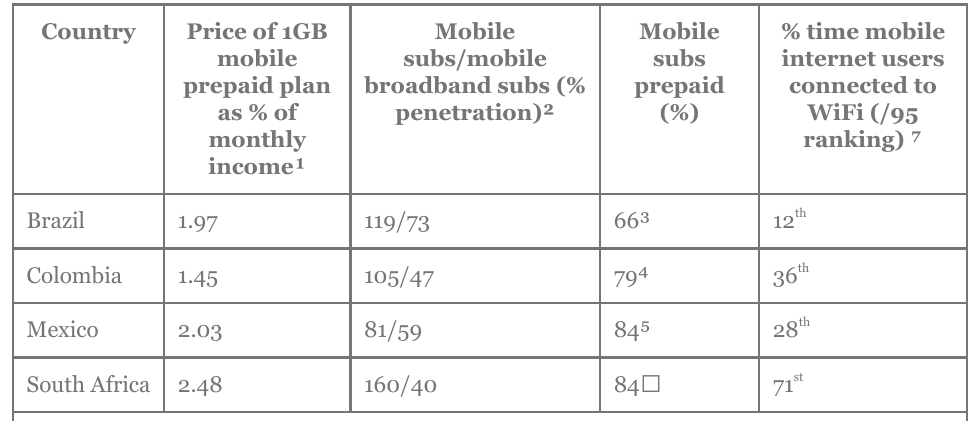
Table 6: Affordability and